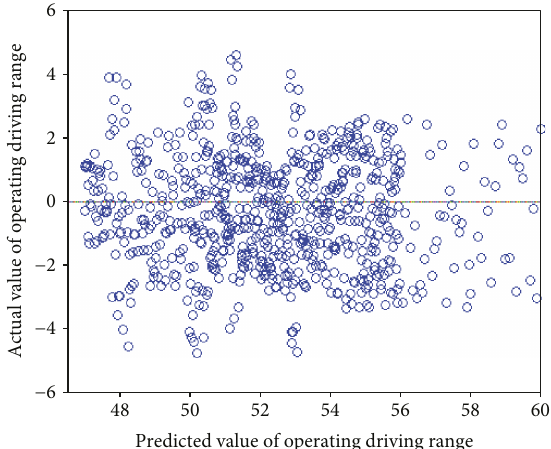
Figure 19: Prediction error distribution (operating driving range,